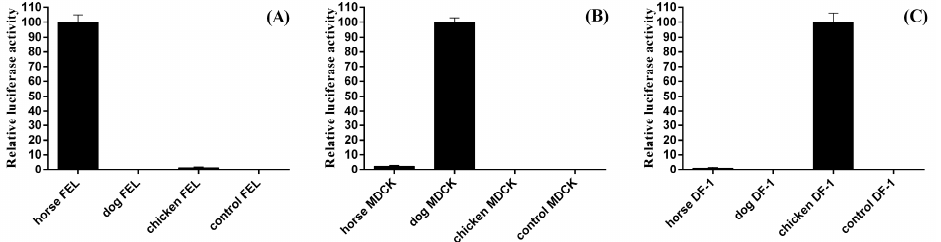
Figure 4. Comparison of transcription efficiency of the horse RNA PolI promoter in FEL, MDCK, and DF-1 cells. The transfection method and the amount of each plasmid was the same as in Figure 2B. The relative luciferase activities associated with the pLW500-NPluci construct in FEL cells ( A ), the pdoPolI-NPluci construct in MDCK cells ( B ) and the pchPolI-NPluci construct in DF-1 cells ( C ) were set as 100%. The relative luciferase activities associated with the pLW0-NPluci construct containing no RNA PolI promoter was used in FEL cells ( A ); MDCK cells ( B ); and DF-1 cells ( C ) as control, respectively. Each experiment was repeated three times.